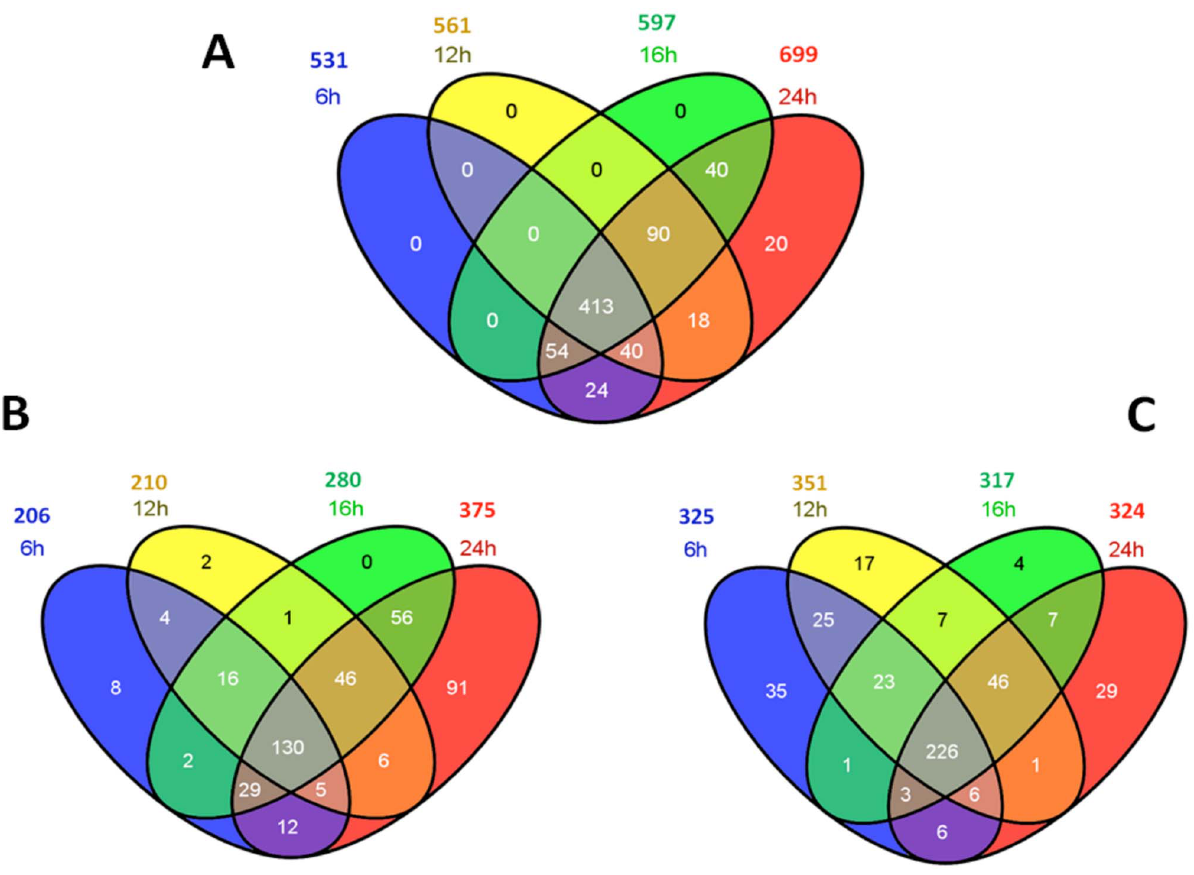
Figure 4. Summary of differentially expressed genes in PAMs infected with PRRSV. All genes (A), up-regulated genes (B) and down- regulated genes at four time-points post-infection (C).